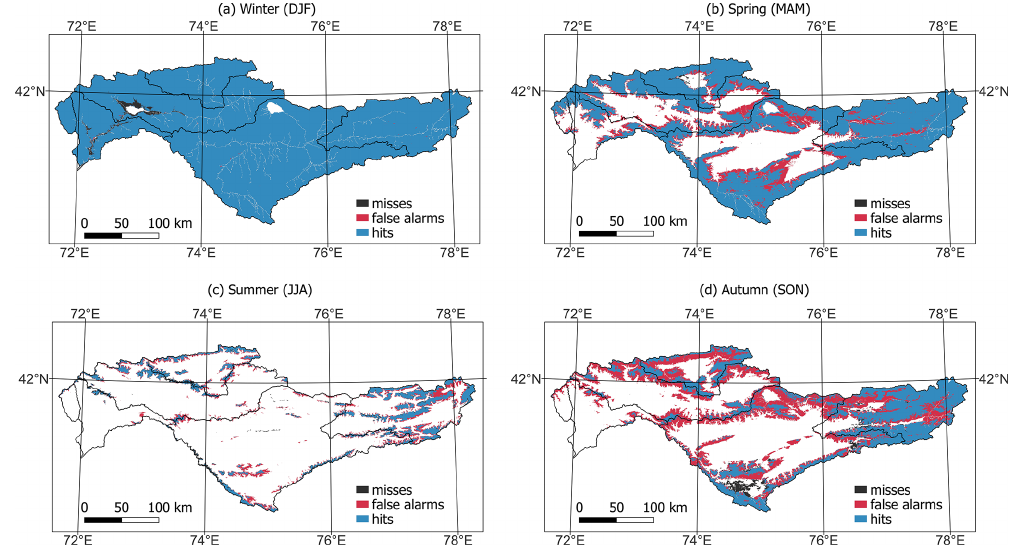
Figure 8. Spatial distribution of the hits, misses and false alarms between the simulated snow extent (median 50th percentile simulation) and MODIS snow extent for the year 2002. Hits, misses and false alarms are defined in Table 5. Table 6. Seasonal validation metrics for MODIS and modelled snow extent for the 5th, median and 95th percentile prediction limits of the best 0.5% calibration runs. Metrics for each season are calculated by averaging annual metrics over the years 2001–2007. Annual metrics are listed in Table S4. Winter (DJF) Spring (MAM) Summer (JJA) Autumn (SON) P